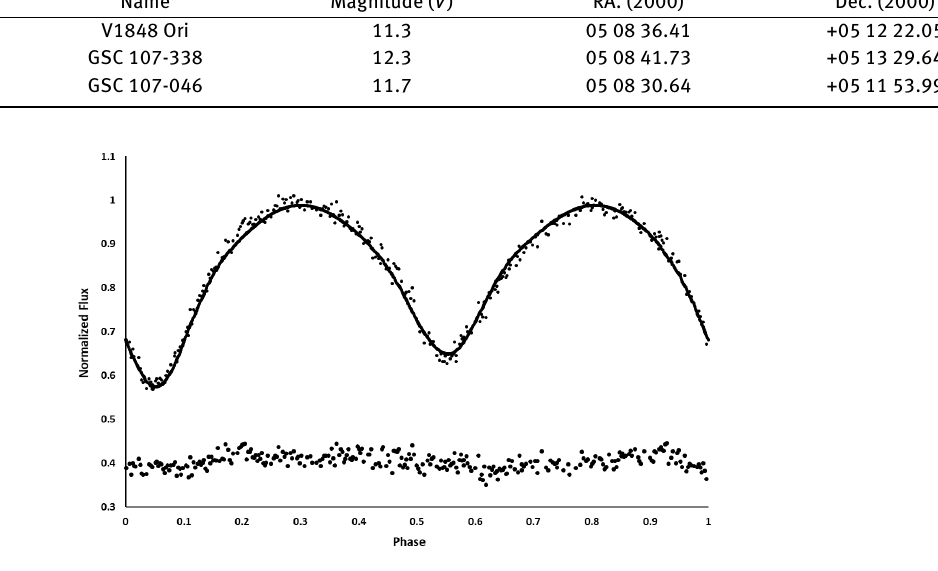
Figure 1. The observed, synthetic light curves, and residuals of V1848 Ori in V filter; with respect to orbital phase and flux for light curves, and shifted arbitrarily in the flux of residuals.